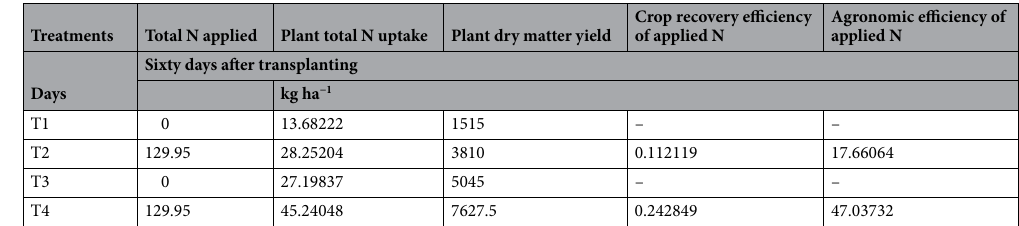
Table 19. Chicken litter biochar application and split application of urea on crop recovery and agronomic efficiency on day sixty after transplanting.